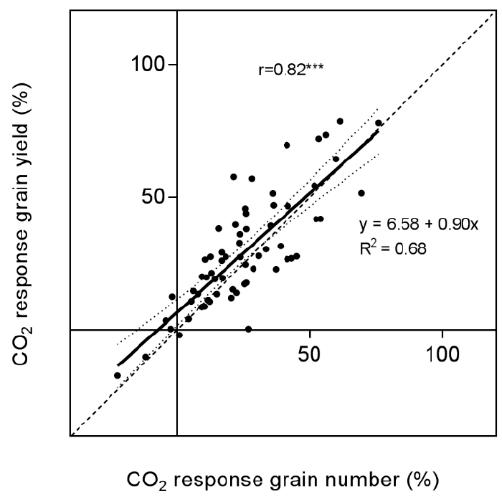
Figure 5. The eCO 2 effect on grain number versus the corresponding effect on grain yield. The broken line (1:1-line) represents the theoretical situation where the effect of eCO 2 on grain yield is entirely explained by the effect on grain number. Dotted lines give the 95% confidence interval for the regression model.